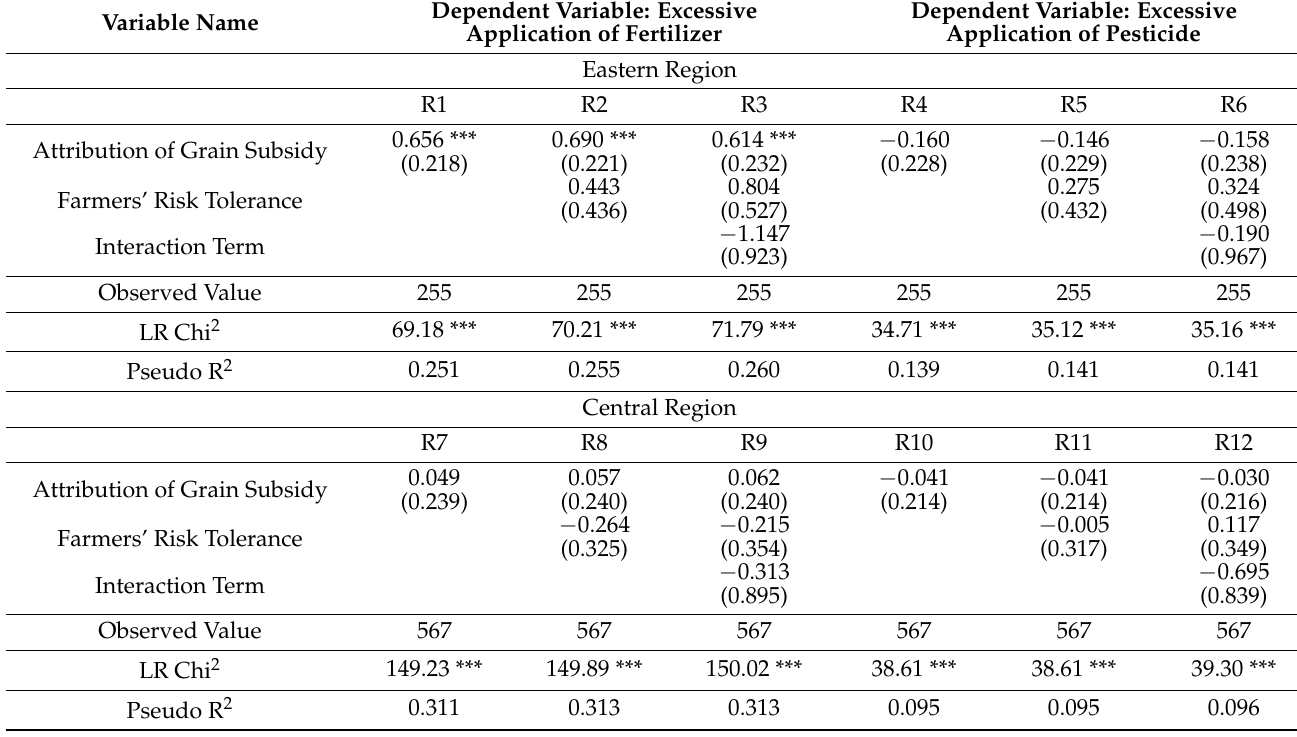
Table 10. Sample grouping regression estimation results based on different